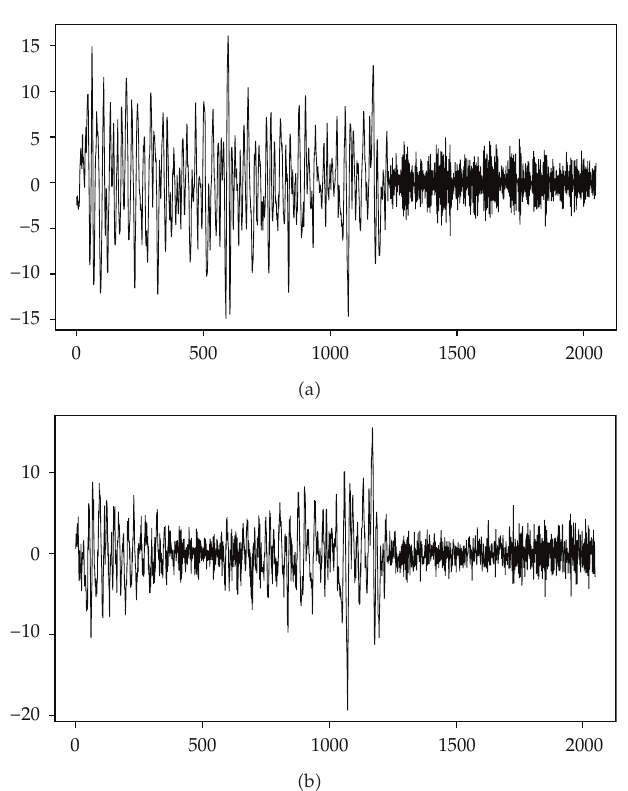
Figure 1: Example 5.1: (cid:5) a (cid:6) input series and (cid:5) b (cid:6) output